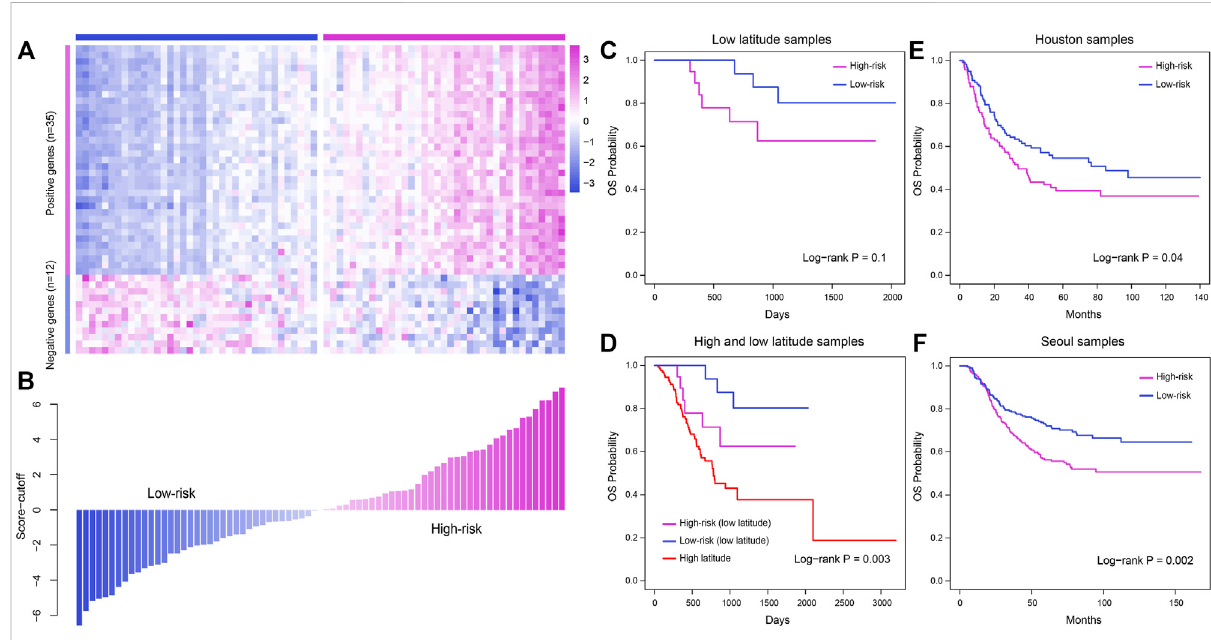
FIGURE 8 Construction and validation of the IRPM model to predict the clinical outcome for patients in low latitude. (A) Expression pro fi le of prognostic immune cell-related marker genes in TCGA low-latitude samples. (B) IRPM score of each sample evaluated using the IRPM model. (C) Meier survival plot of high- and low-risk samples in low latitudes. (D) Kaplan – Meier survival plot of samples in high and low latitudes. (E – F) Validation of the prognostic effect of the IRPM model in two GEO cohorts, including Houston samples (E) and Seoul samples (F)